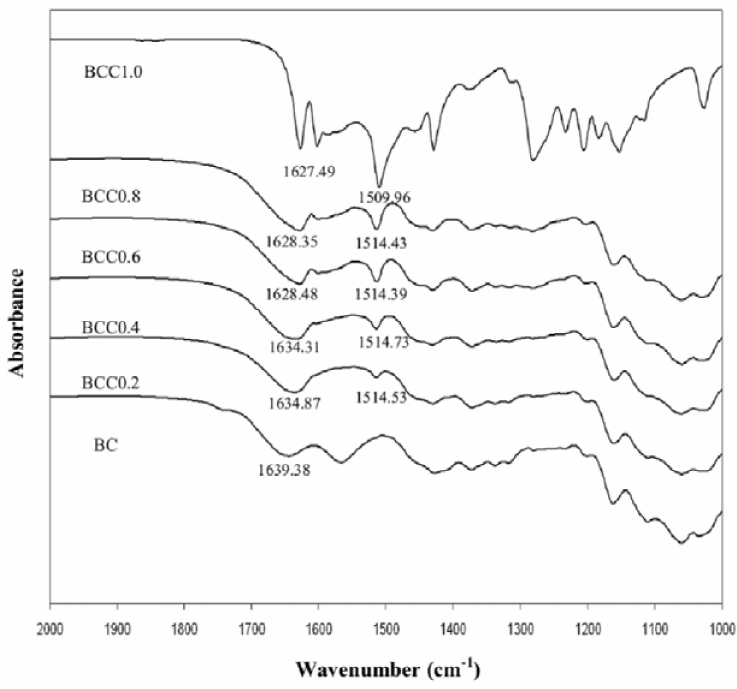
Figure 3. FTIR spectra of BC, BCC0.2, BCC0.4, BCC0.6, BCC0.8 and